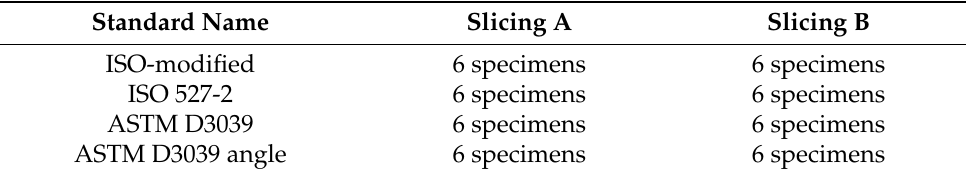
Table 6. Experimental design with different specimen types and slicing approaches, all produced and tested on six specimens to obtain a statistical confidence interval.